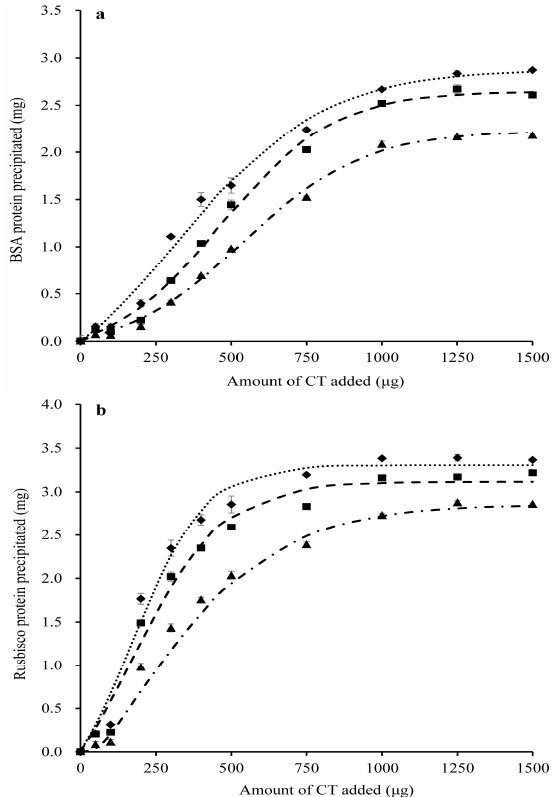
Figure 2. Precipitation of bovine serum albumin (BSA; a ) and spinach ribulose 1,5-disphosphate carboxylase (Rubisco; b ) by condensed tannins (CT) isolated from freeze-dried purple prairie clover ( ♦ FD), or conserved as hay ( ■ HAY) or silage ( ▲ SIL). The dash lines relate to corresponding CT data which were fitted to a SigmaPlot curve as described under statistical analysis. Bars indicate standard error and where not visible, fall within symbols. Table 4. Precipitating capacities of condensed tannins from purple prairie clover conserved as freeze-dried forage (FD), hay (HAY) or silage (SIL). Protein 1